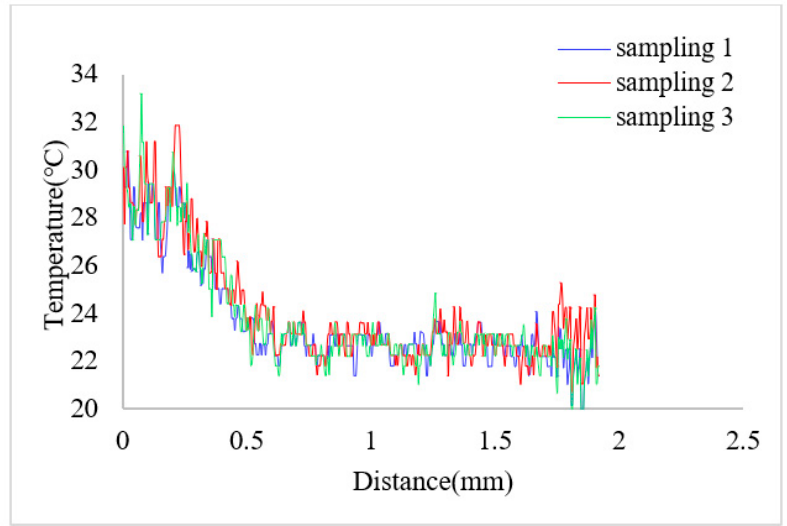
Figure 13. Temperature variation along the mark line (in Figure 10) when the applied apparent power is 4.29 VA.